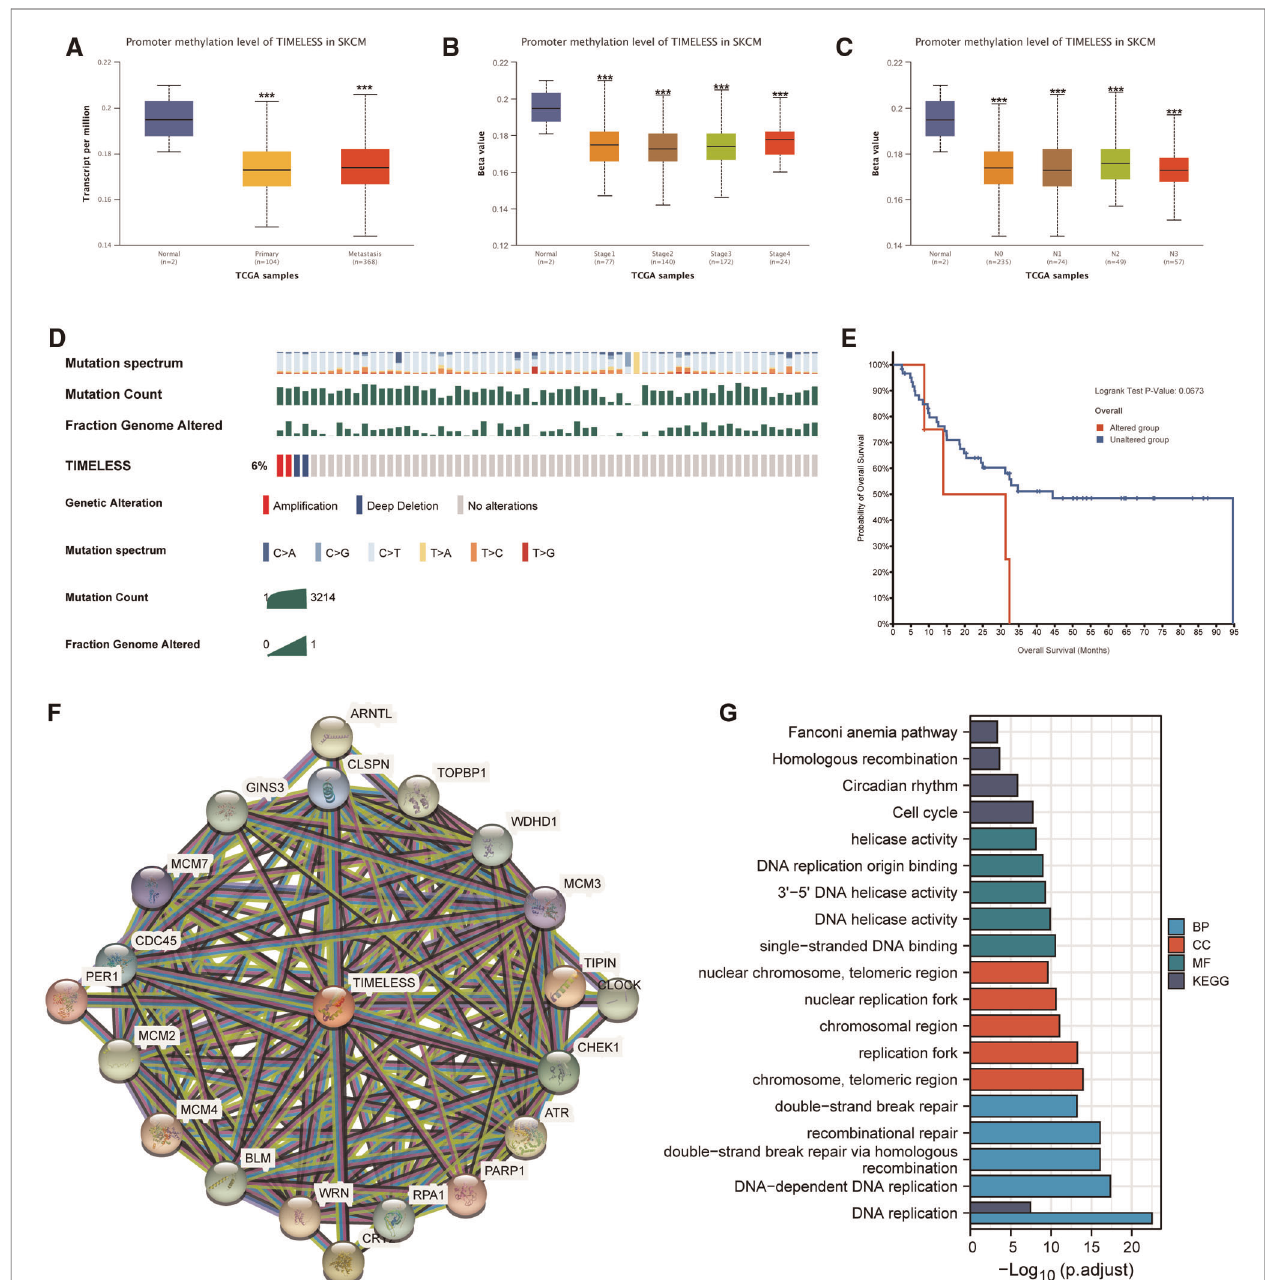
FIGURE 6 | Promoter methylation and genetic alterations of TIM and potential regulatory mechanism of TIM in regulating SKCM. ( A – C ) Relationship between tumor type, stage, and nodal metastasis status of SKCM with the promoter methylation of TIM determined using UALCAN. ( D ) Genetic alterations of TIM in SKCM patients determined using cBioportal. ( E ) OS for TIM alterations was analyzed using cBioportal. ( F ) The neighbor gene network of 20 genes was constructed using STRING. ( G ) The bar diagrams showed the top fi ve terms for each GO category as well as for the KEGG pathway analysis. *** p